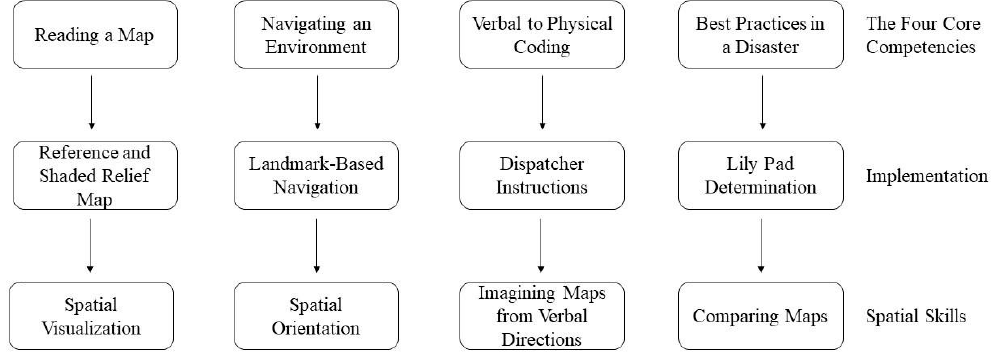
Figure 5. Diagram showing how Project Lily Pad helps improve the four spatial abilities of an individual that are needed to deal with a disaster.